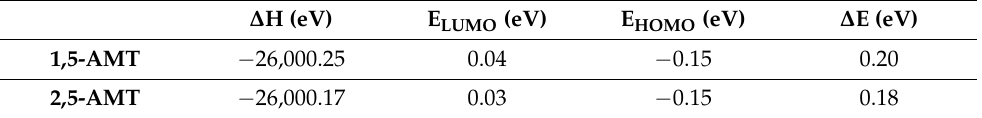
Table 4. Calculated quantum chemical parameters of organic compounds 1,5-AMT and 2,5-AMT using DFT method with 6-31G (d) basis set in aqueous